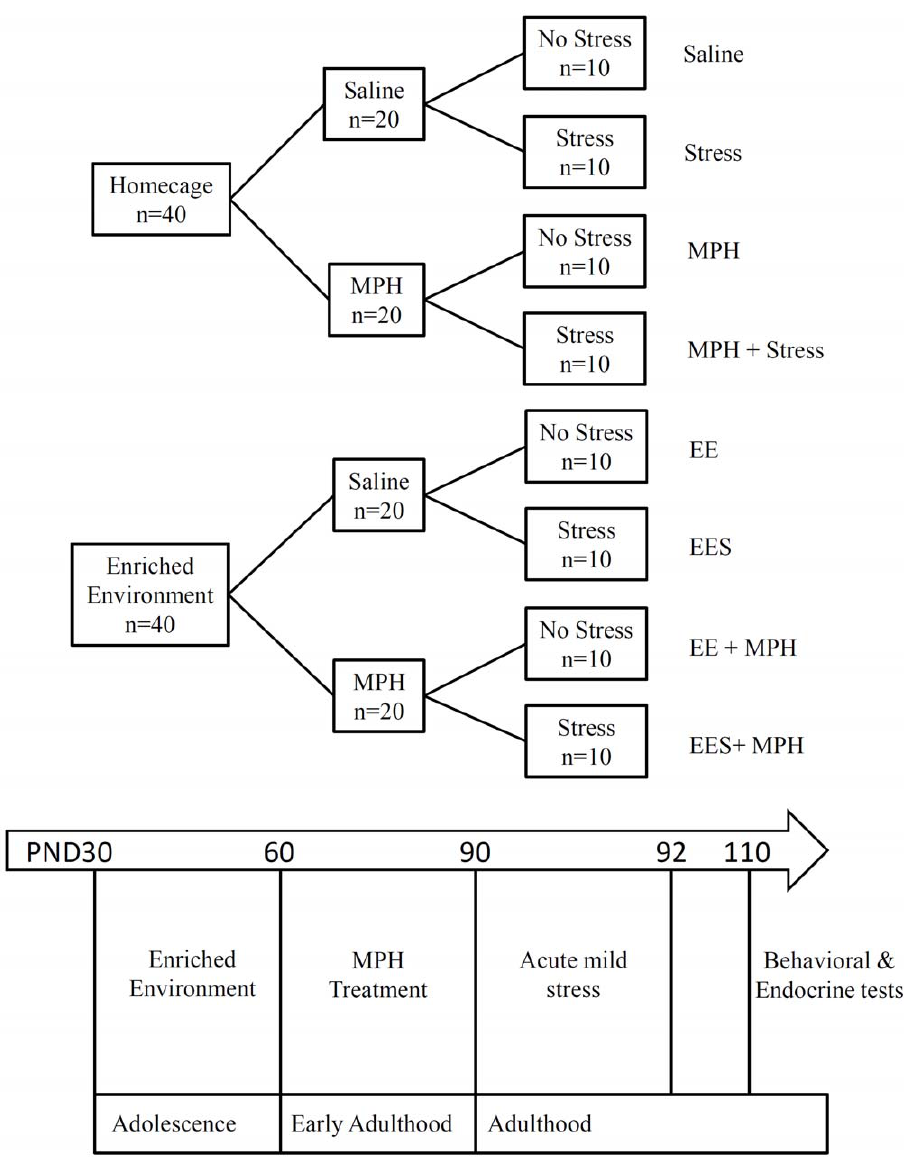
Figure 1. Schematic diagram of experimental design and procedures.